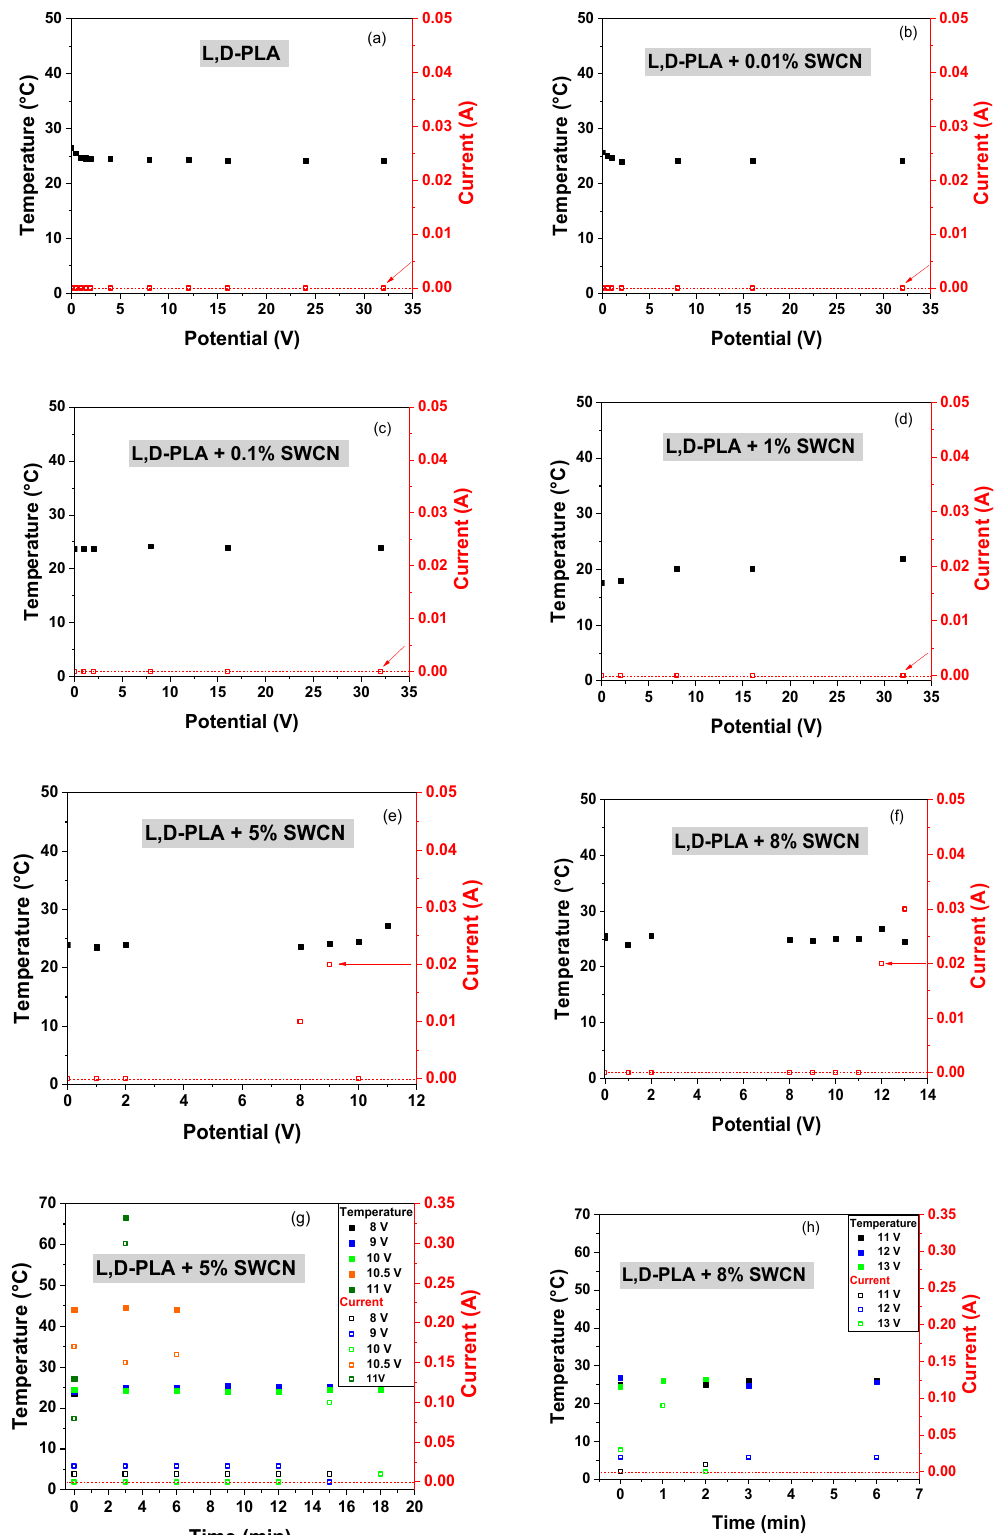
Figure 8. The correlation of temperature and current at different applied potentials for the film L , D -PLA ( a ) and films based on L , D -PLA containing 0.01% ( b ), 0.1% ( c ), 1% ( d ), 5% ( e ) and 8% ( f ) SWCN, together with the correlation of temperature and current over time for films based on L , D -PLA containing 5% ( g ) and 8% ( h ) SWCN; before mechanical